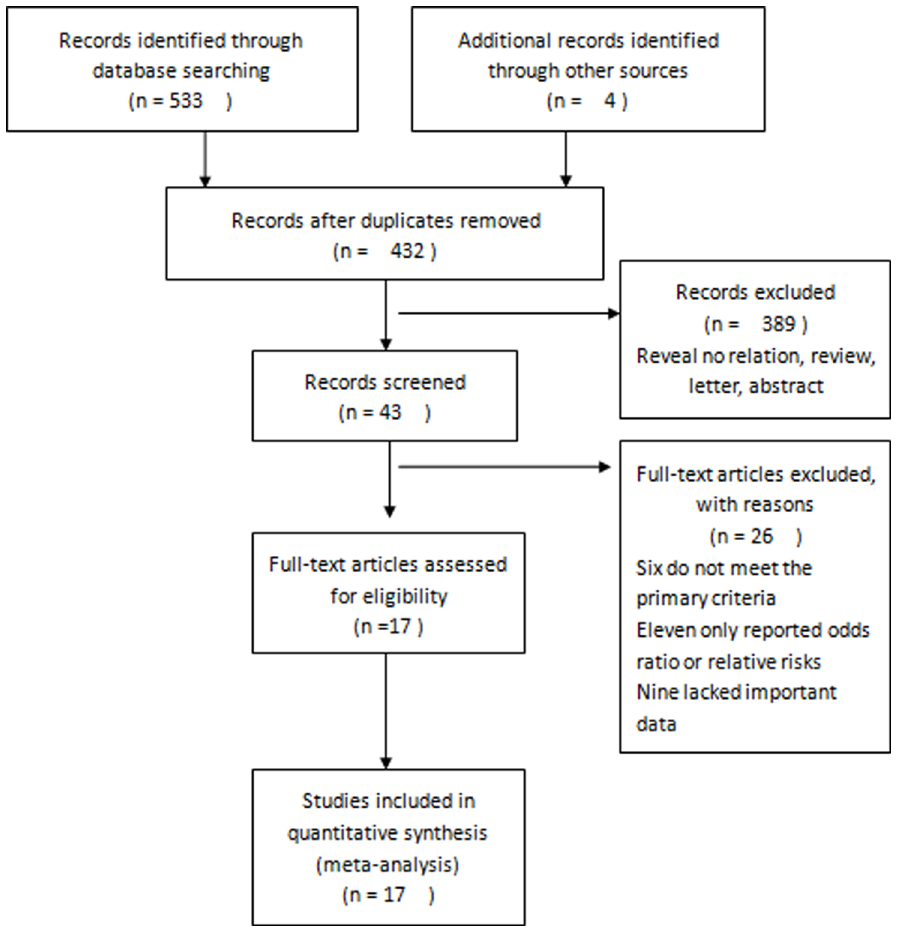
Fig 1. Flow diagram of the study selection